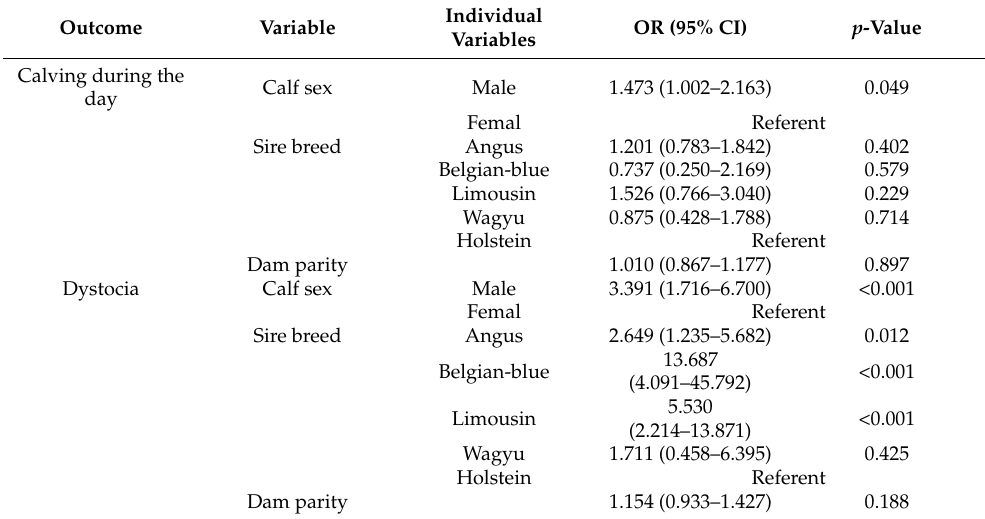
Table 3. Factors associated with day- or night-calving and with the occurrence of